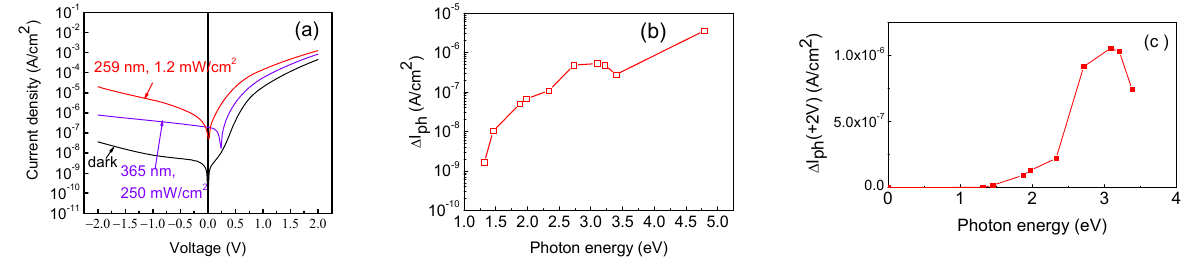
these low probing frequencies. The temperature dependence of the capacitance deriva ‐ tive by temperature, d C /d T , at these low frequencies shows a distinct peak whose posi ‐ tion shifts to lower temperatures as the frequency decreases (Figure 10b presents the data for several frequencies). Standard admittance spectroscopy analysis [46,47] gives the depth of the traps responsible for the peak at 0.7 eV, with an electron capture cross ‐ section S n of 10 − 15 cm 2 ; meanwhile, C ‐ V measurements at these high temperatures and low frequencies yield a trap concentration of 1.2 × 10 17 cm − 3 in the near surface sub ‐ micron region of the film [41]. At high frequencies, the 0.7 eV centers cannot respond to the probing frequency in capacitance measurements; meanwhile the region in which these traps are dominant behaves as a dielectric layer whose capacitance is switched in series with the less resistive part of the film, in which shallower donors with levels near 0.3 eV and a concentration of 6 × 10 15 cm − 3 are prevalent [41]. 0.01 (b) Figure 10. ( a ) C ‐ f characteristics at three temperatures; ( b ) dC/dT for several measurement fre ‐ quencies: 20 Hz (red), 30 Hz (blue) and 50 Hz (olive).